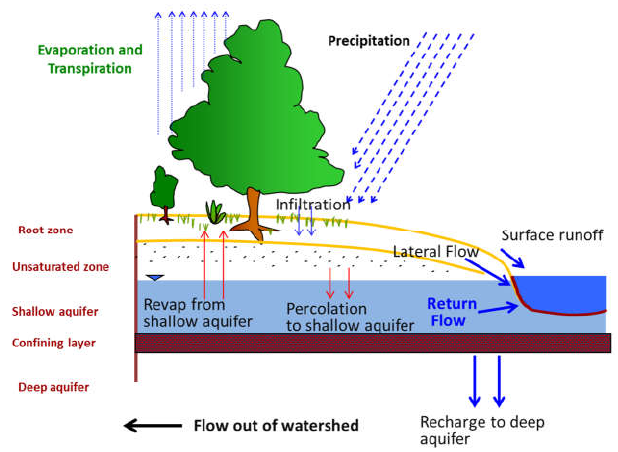
Figure 2. Hydrological cycle in the Soil and Water Assessment Tool (SWAT) model (adopted from SWAT model manual).